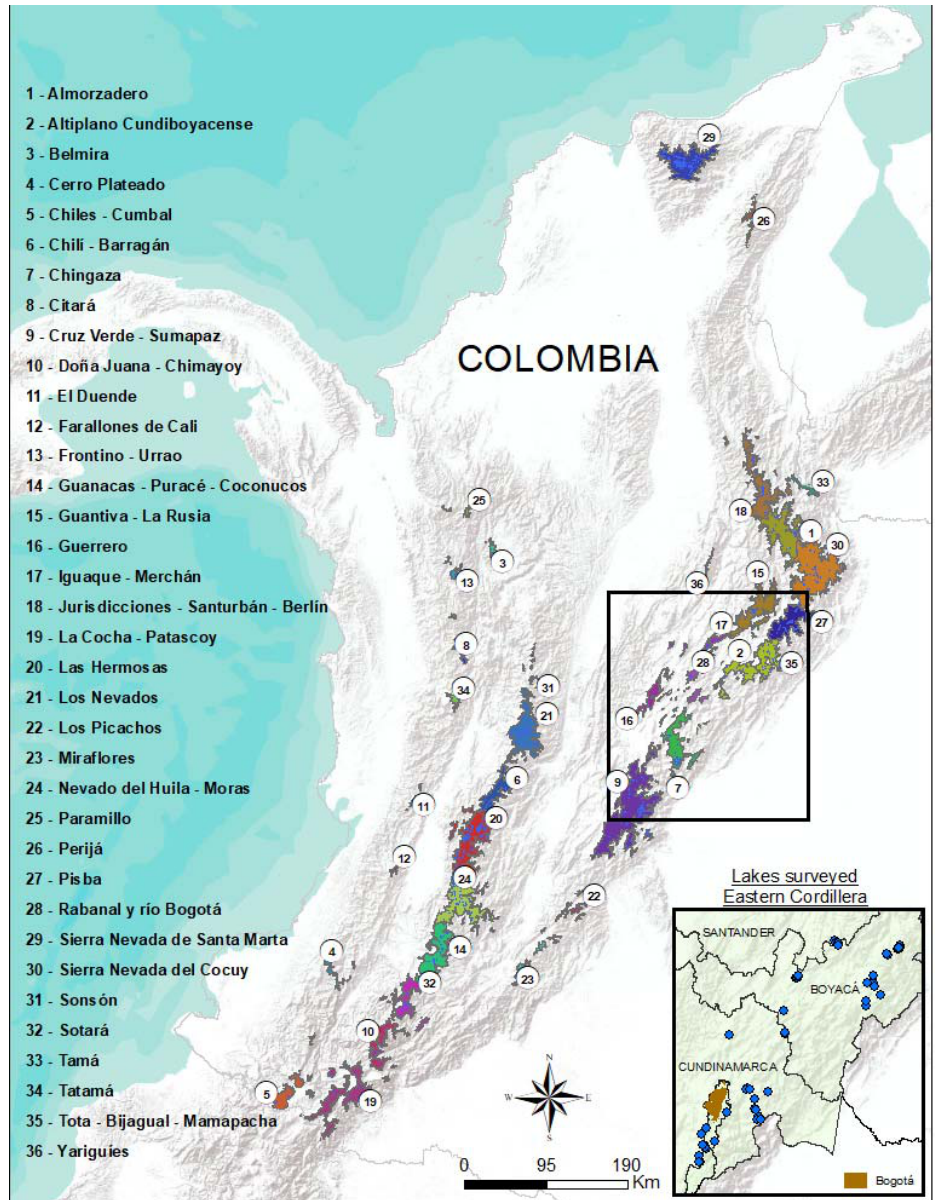
Figure 1. Distribution of páramo complexes in Colombia. Adapted from Instituto de Investigación de Recursos Biológicos Alexander von Humboldt (2013, 2021). The box shows the distribution of the lakes sampled for the physical and chemical study.